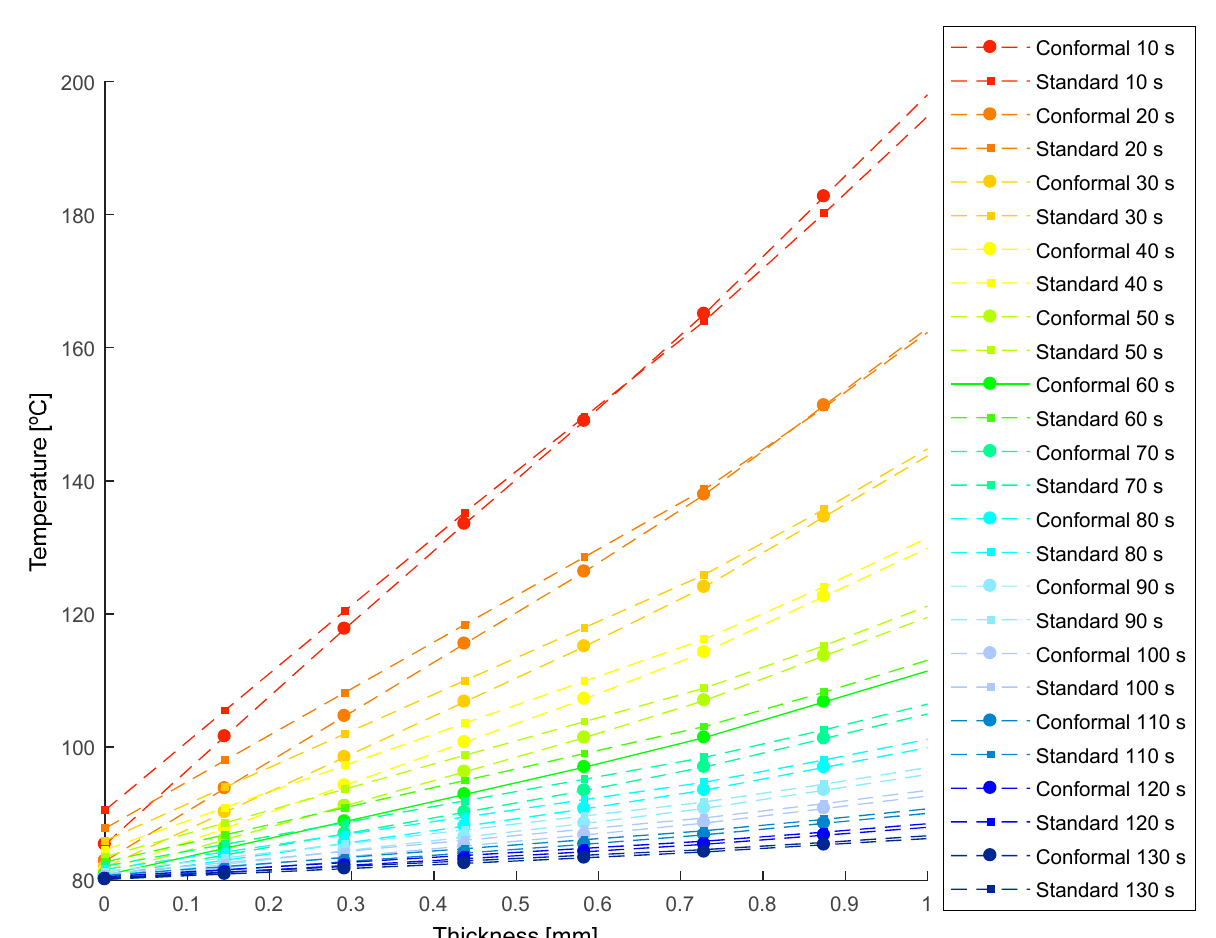
Figure 19. Temperature profile of the plastic part [ ◦ C] versus the thickness [mm] resulting in the collimator region during the transient numerical analysis.